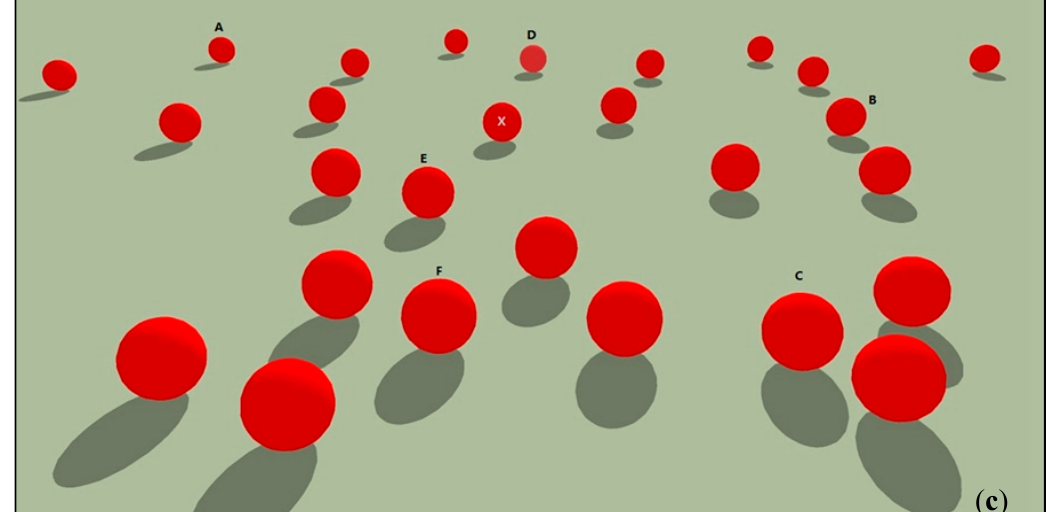
Figure 4. ( a ) In Exp. 2.1, intended to investigate size constancy, Object F was expanded to 120% of its original size; ( b ) In Exp. 2.2, intended to investigate shape constancy, Object D was changed to a cone; ( c ) In Exp. 2.3, intended to investigate color constancy, the color saturation of Object D was decreased to 75% of its original value.